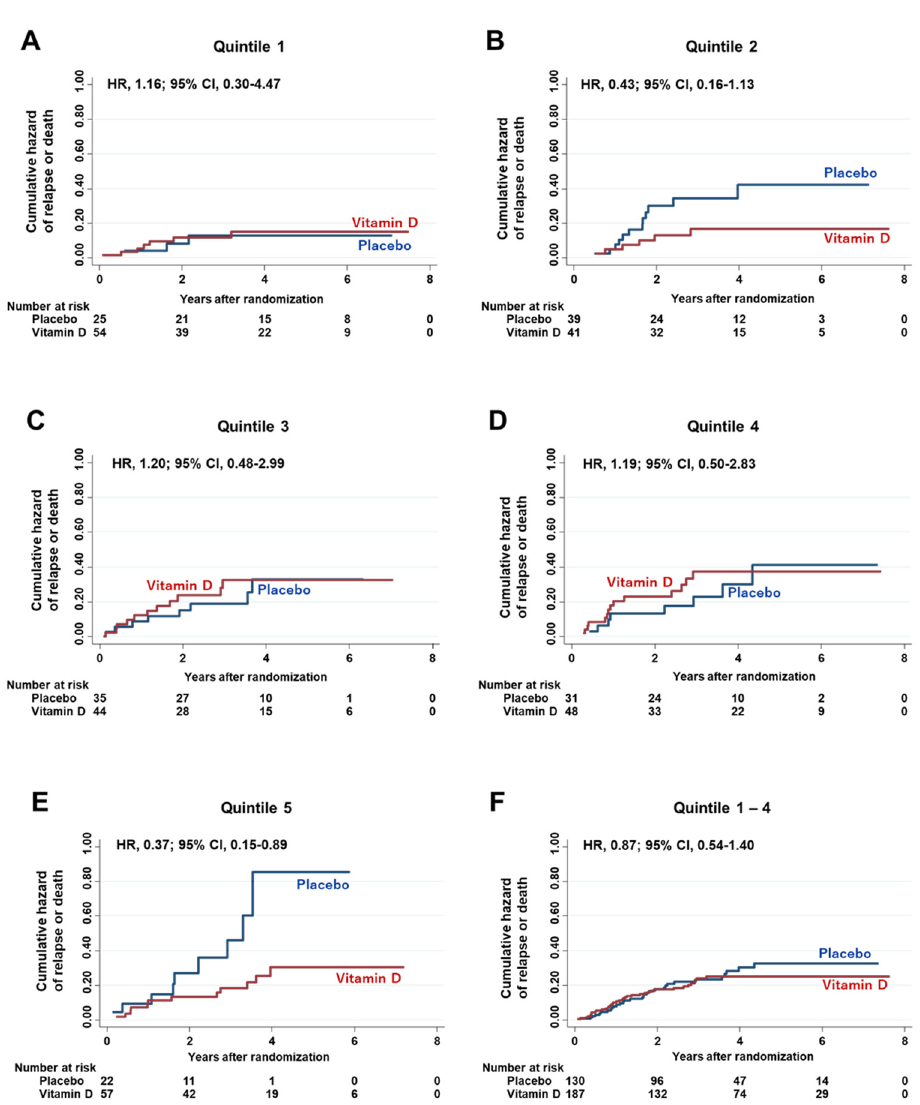
Figure 5. Cumulative hazard curves for relapse or death. Nelson–Aalen cumulative hazard curves ( A ) for relapse or death in the subgroup of 1st quintile of serum PD-L1 levels (Quintile 1), ( B ) for relapse or death in the subgroup of 2nd quintile of serum PD-L1 levels (Quintile 2), ( C ) for relapse or death in the subgroup of 3rd quintile of serum PD-L1 levels (Quintile 3), ( D ) for relapse or death in the subgroup of 4th quintile of serum PD-L1 levels (Quintile 4), ( E ) for relapse or death in the subgroup of 5th quintile of serum PD-L1 levels (Quintile 5), ( F ) for relapse or death in the subgroup of the sum of Quintile 1 to Quintile 4 of serum PD-L1 levels. HR = Hazard ratio; CI = Confidence interval.